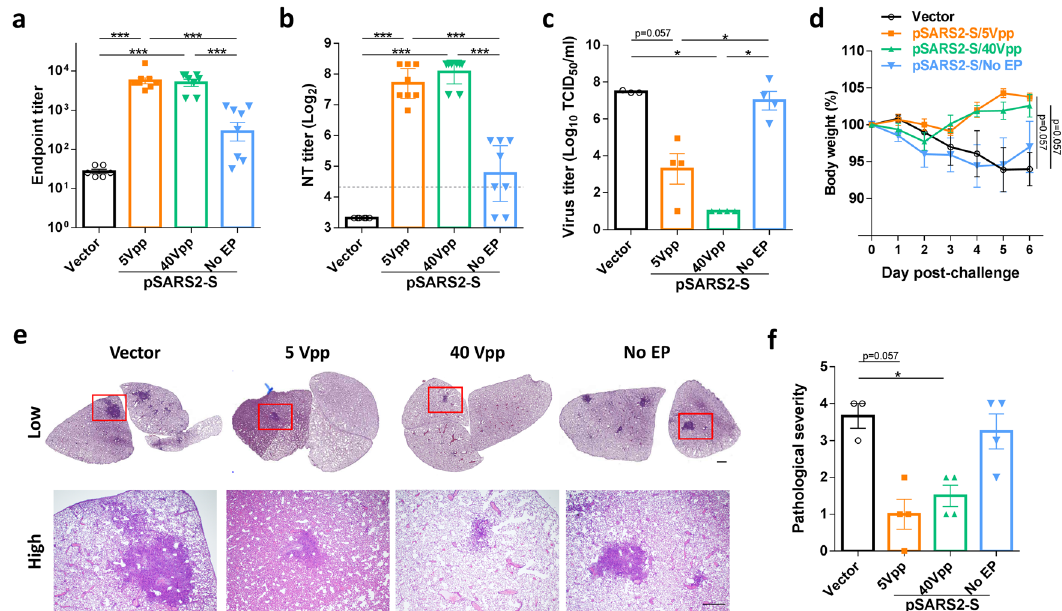
Fig. 5 Prophylactic ef fi cacy of the pSARS2-S DNA vaccine with or without electrostimulation against SARS-CoV-2 challenge. Syrian hamsters ( n = 6 for vector; n = 8 for 5, 40 Vpp and No EP) were intramuscularly immunized twice at a 3-week interval with 100 μ g of vector control, 100 μ g of pSARS2-S followed by electrostimulation at the indicated voltage and 120 Hz for 5 s, or 100 μ g of pSARS2-S without electrostimulation (No EP). Serum samples were collected at week 6 after the fi rst immunization. At 3 weeks after the fi nal immunization, Syrian hamsters were intranasally challenged with 10 5 TCID 50 SARS-CoV-2. a Spike-speci fi c IgG antibodies were detected by ELISA. b Neutralization titers against wild-type SARS-CoV-2 were examined by neutralization assay. The dashed line indicates the initial fold dilution of serum samples. c Viral titers in the lungs of SARS-CoV-2-infected hamsters at 3 days postchallenge were determined by TCID 50 assay. d The body weight change (%) of the hamsters was recorded every day after SARS-CoV-2 challenge. e Histopathology of lungs from infected hamsters at 6 days postchallenge was examined by hematoxylin and eosin staining. Scale bar for the low-magni fi cation image: 1 mm, scale bar for the high-magni fi cation image: 500 μ m. f Pathological severity scores of infected hamsters. Neutralization titers are expressed as the geometric mean with a 95% con fi dence interval, and other data are presented as the mean ± SEM. * p < 0.05, *** p < 0.001 by the Mann – Whitney